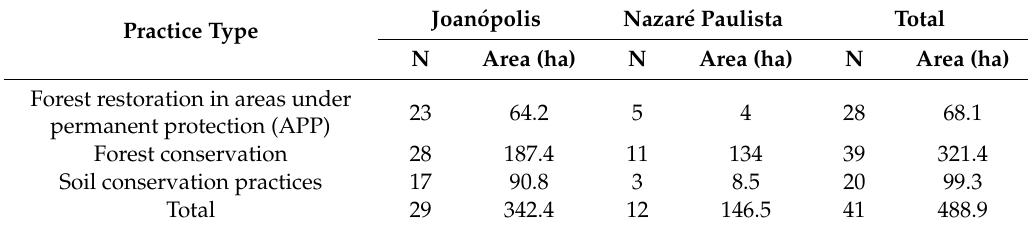
Table 2. Number of properties (N) and areas of implementation for the FLR practices involved in the Water Producer Project in the Joan ó polis and Nazar é Paulista municipalities, Piracicaba, Capivari, and Jundiai Watershed, Atlantic Forest, Brazil.